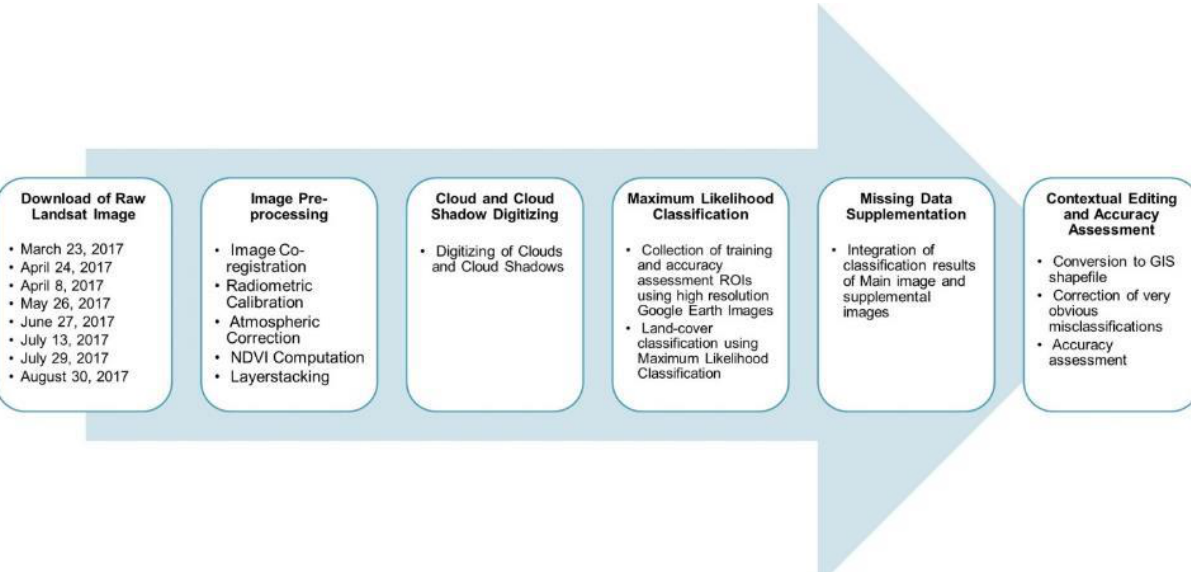
Figure 2 . Location of the Agusan Marsh within the Agusan River Basin (ARB) in Mindanao, Philippines. Within the marsh floodplain is the Agusan Marsh Wildlife Sanctuary (AMWS), a protected area.